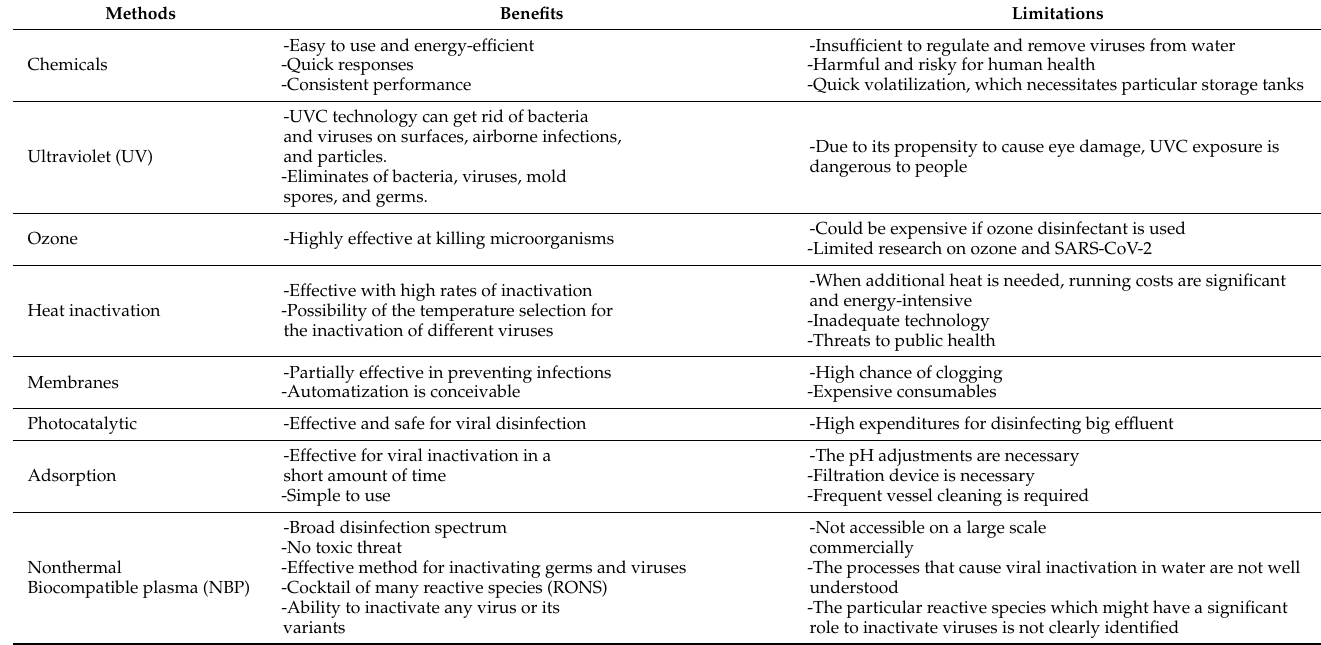
Table 1. Summary of methods to inactivate viruses inside